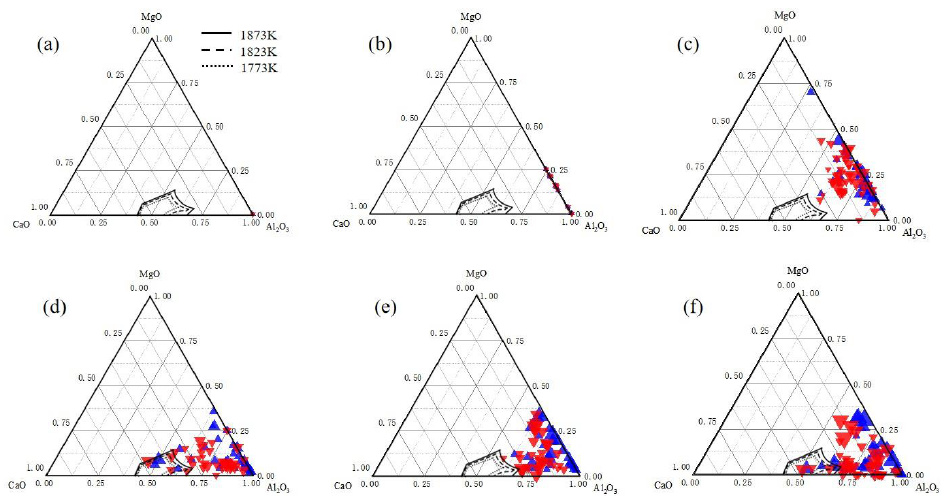
Figure 7. Composition of inclusions when adding Ca after Mg ( a ) 30 s after Al addition, ( b ) 30 s after Mg addition, ( c ) 30 s after Ca addition, ( d ) 5 min after Ca addition, ( e ) 15 min after Ca addition, ( f ) 30 min after Ca addition.